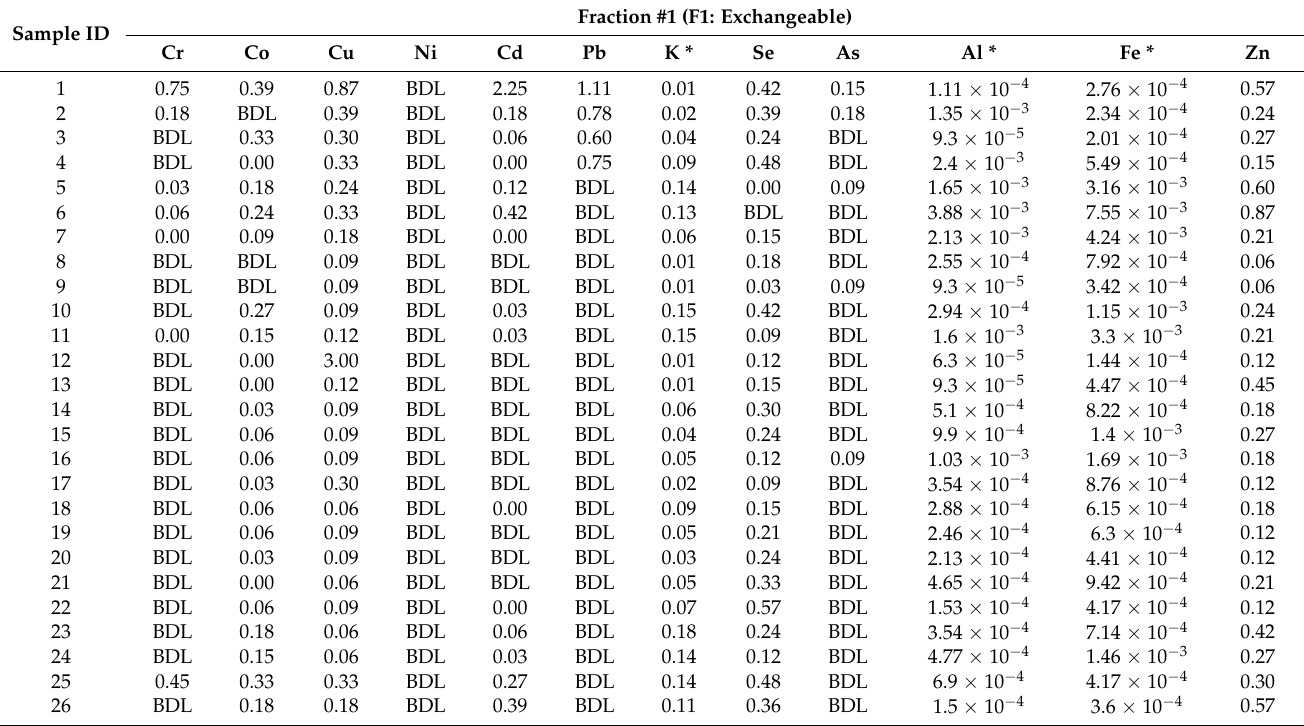
Table A1. PTE concentrations for each fraction. Concentrations are in mg/kg and in percent (*). (BDL = Below Detection